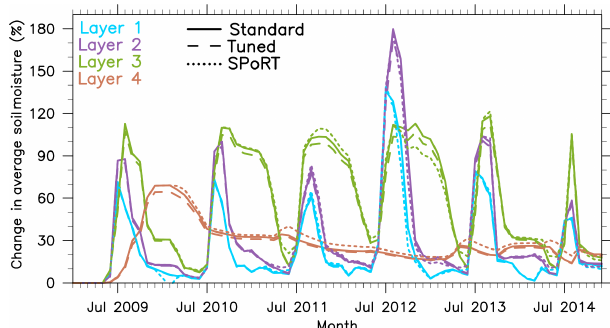
Figure 4. Change from Control (irrigation runs – Control) in soil moisture for each experiment (line style) and each layer (line color). Layer designations are the Noah LSM default layers: layer 1 (top layer) is 0 to 10cm depth ( δ Z = 10cm), layer 2 is 10 to 40cm (delta Z = 30cm), layer 3 is 40cm to 1m ( δ Z = 60cm), and layer 4 is 1 to 2m ( δ Z = 100cm).